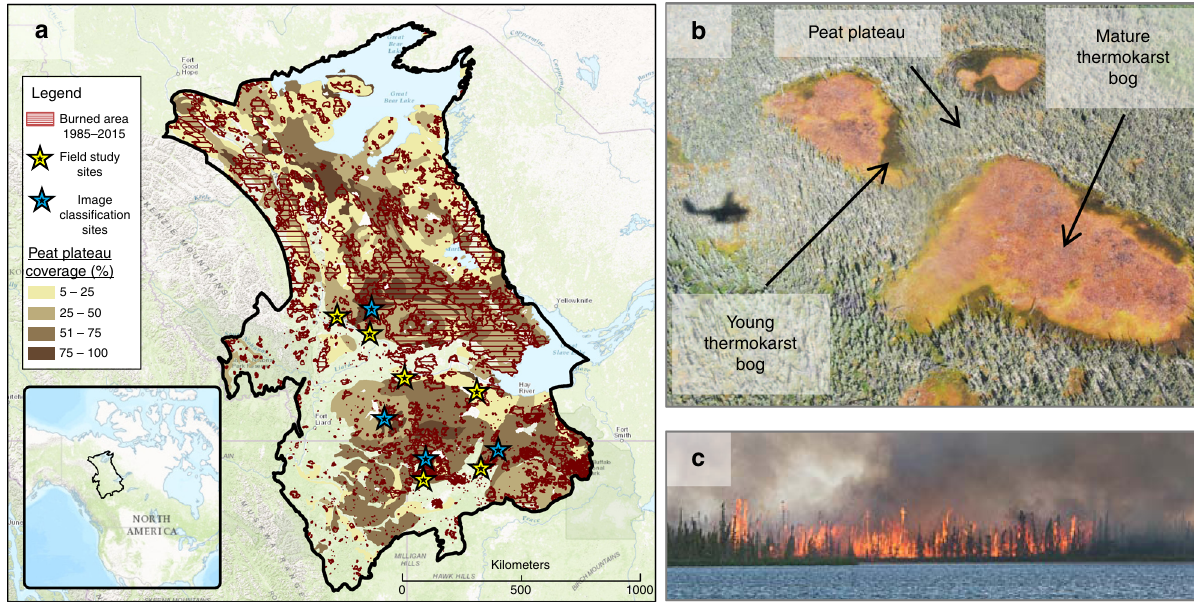
Fig. 1 Wild fi re in western Canadian peatlands. a Outline of the study region, de fi ned as the discontinuous and sporadic permafrost zones 56 within the Taiga Plains ecozone 59 . Shading shows coverage of peat plateaus as indicated by the distribution of histel soils 58 . Historical burned areas from the last 30 years are shown as hashed areas 57 . Yellow stars indicate locations where soil thermal regime was monitored, with one unburned and at least one burned site at each star location. Blue stars indicate locations where satellite image classi fi cation of young thermokarst bog extents were assessed within large peatlands partially affected by wild fi re. b Example of a peatland characteristic for the study region, with three non-treed thermokarst bogs without permafrost surrounded by treed permafrost peat plateau. Distinct young thermokarst bog stages are visible as green areas along some peat plateau edges, resulting from recent permafrost thaw. Photo copyright Mason Stothart. c Example of a characteristic crown fi re burning a peat plateau, near Fort Simpson, NWT,